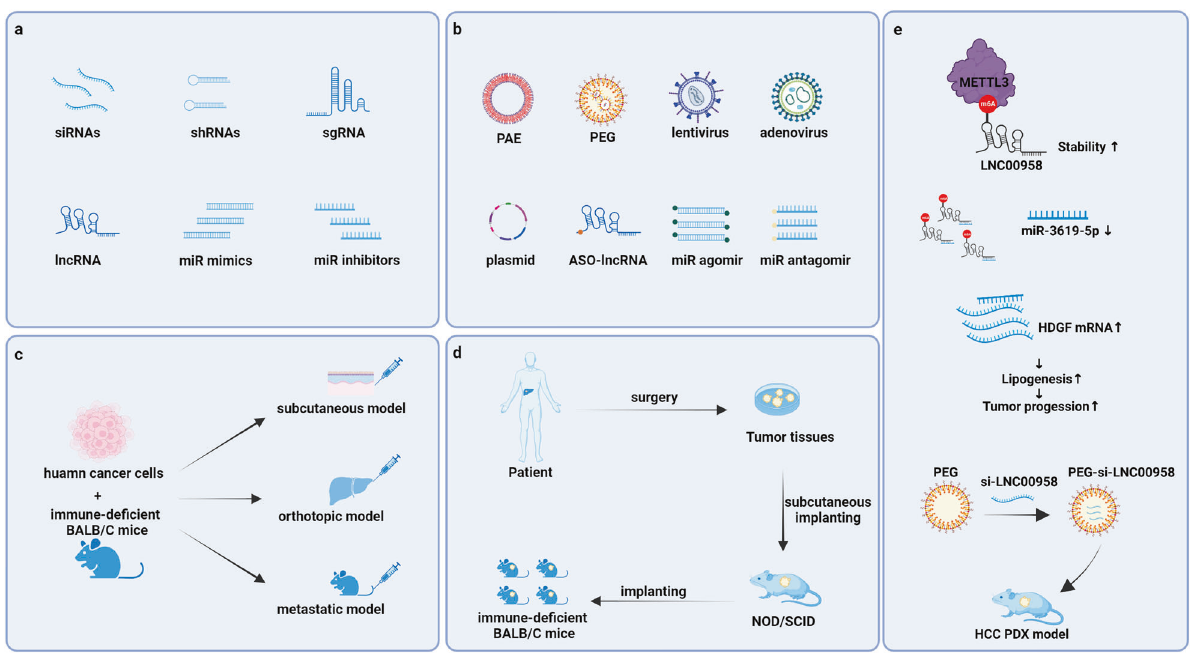
Fig. 5 ncRNA-based therapeutics and delivery systems in a mouse model. Several ncRNA-based therapeutics exist, including siRNAs, shRNAs, sgRNAs, therapeutic lncRNAs, miRNA mimics and miR inhibitors ( a ). These therapeutic ncRNAs can be delivered by some vectors, including PAE, PEG, lentivirus, adenovirus and plasmids, and can also be administered in the forms of ASO-lncRNAs, miR agomirs, and miR antagomirs to play a therapeutic role ( b ). ncRNA-based therapy has been shown to be effective in cell-derived xenograft (CDX) models, including subcutaneous, orthotopic and metastatic models ( c ). ncRNA-based therapy has been shown to be effective in patient-derived tumor xenograft (PDX) models ( d ). Lnc00958 sponges miR3619-5p in HCC, leading to the upregulation of hepatoma-derived growth factor and thereby promoting HCC adipogenesis and progression. In the PDX model, the weight and volume of the xenografts were signi fi cantly reduced after tail vein injection of PLGA-PEG (si-LINC00958) NPs ( e